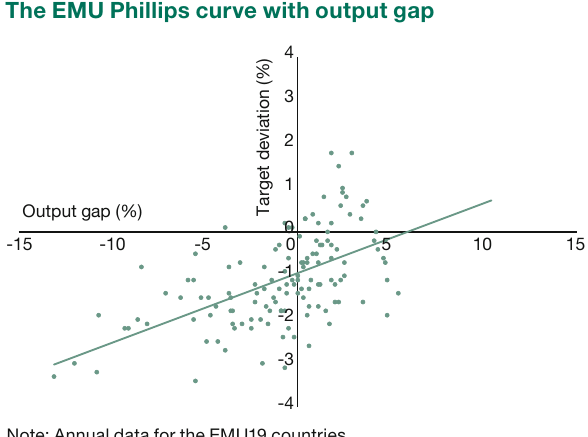
Note: Annual data for the EMU19 countries.